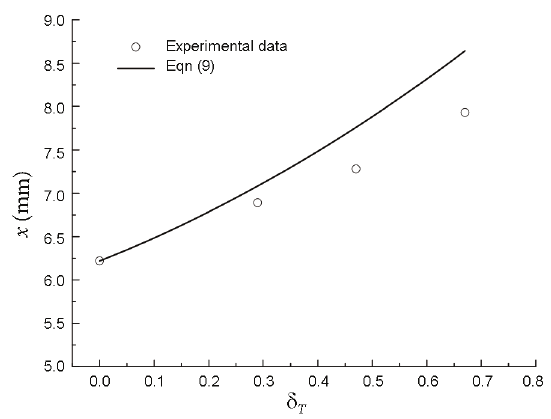
Figure 10. Comparison between the computed results from Eqn (9) and the experimental data from Liu (2008b)